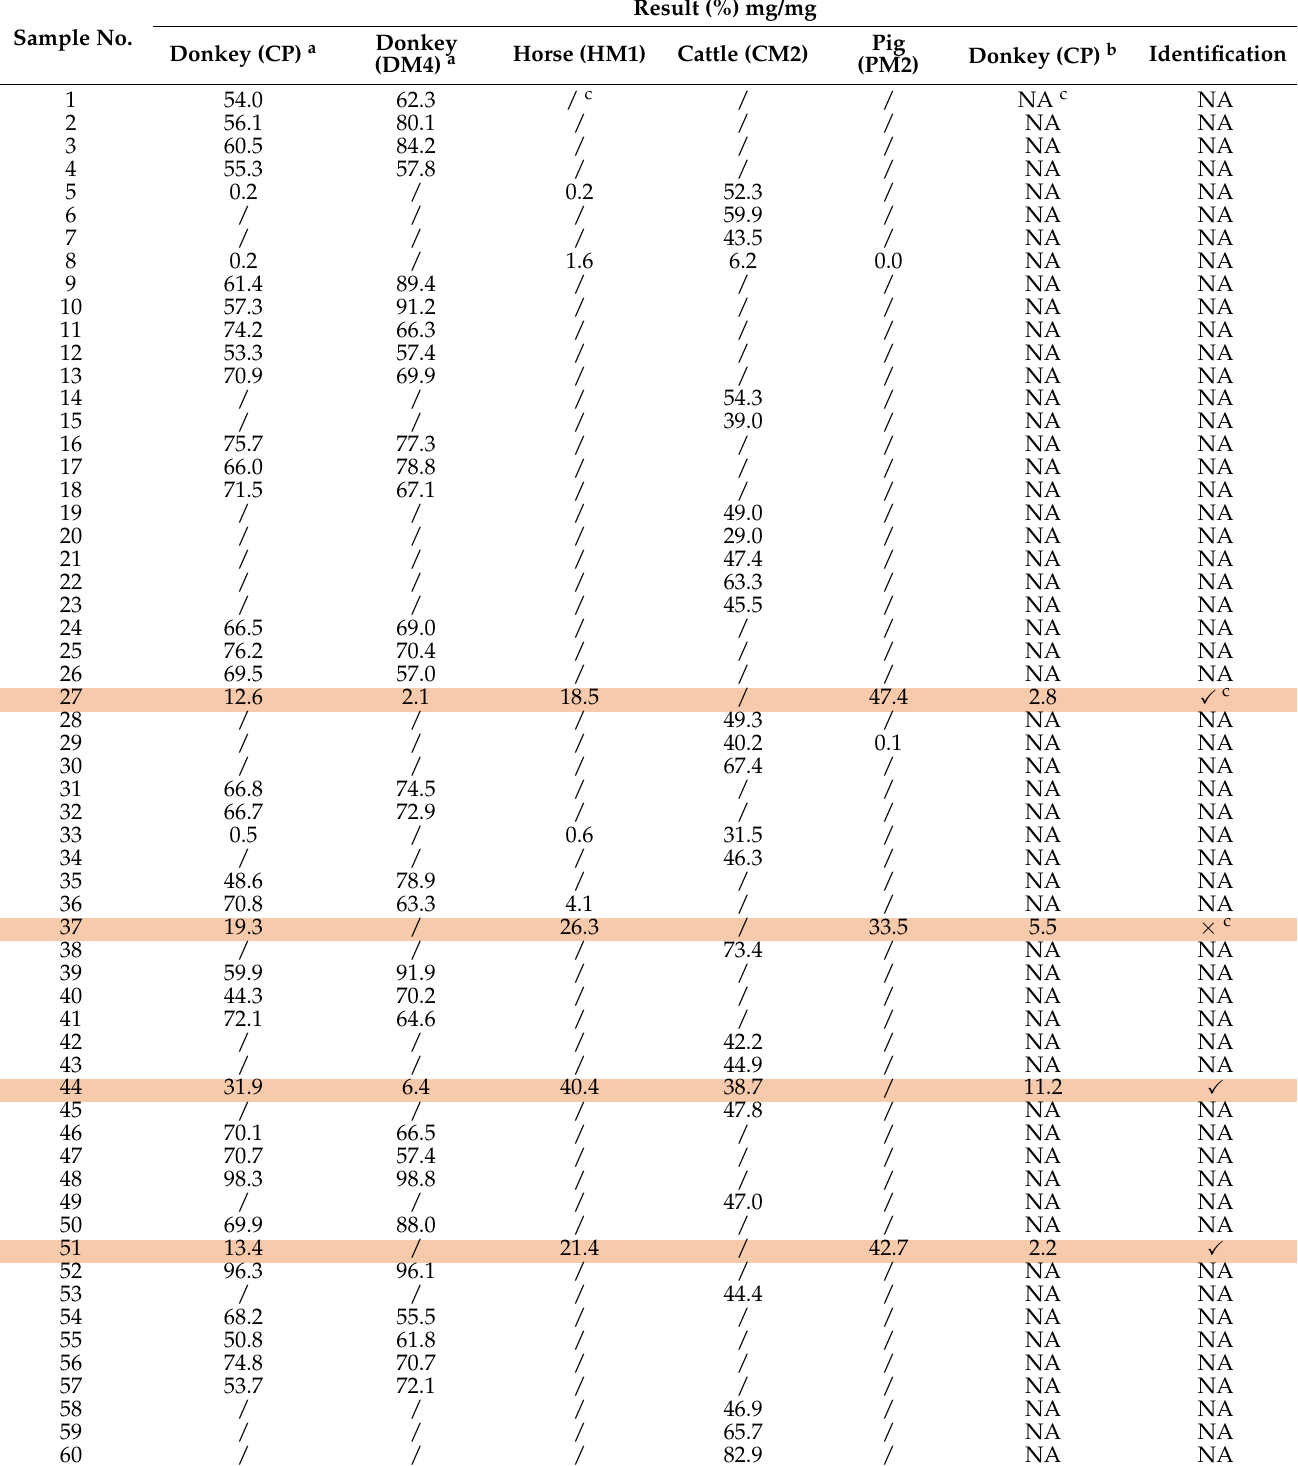
Table 6. Quantitative results of commercial donkey-hide gelatin samples based on our marker and the markers in the Chinese Pharmacopoeia. Molecules 2022 , 27 , x FOR PEER REVIEW